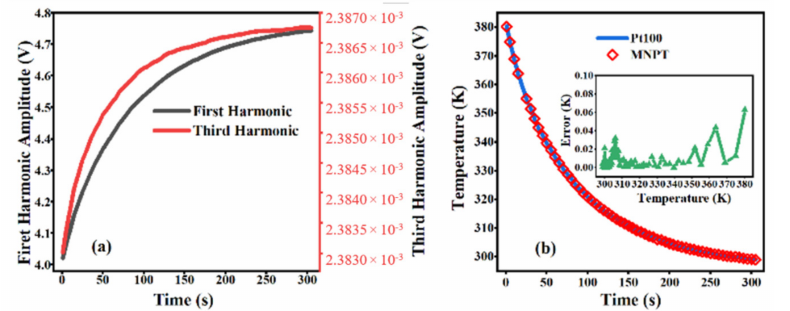
Figure 5. ( a ) The changing of harmonics in cooling of magnetic nanoparticles. ( b ) Temperatures were measured using the 2-D temperature imaging system and a Pt100 thermometer. The illustration is the temperature error between the 2-D temperature imaging system and a Pt100